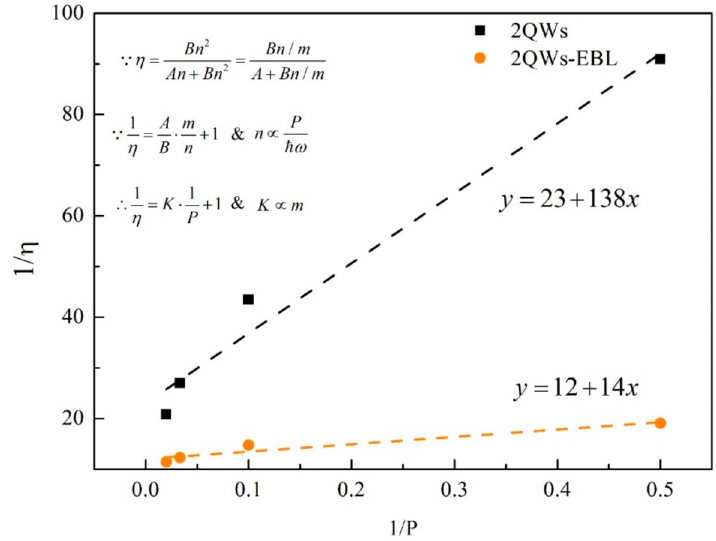
Figure 8. The data and fitting line of reciprocal of IQE versus the reciprocal of excitation power for sample 2QW and 2QW-EBL.